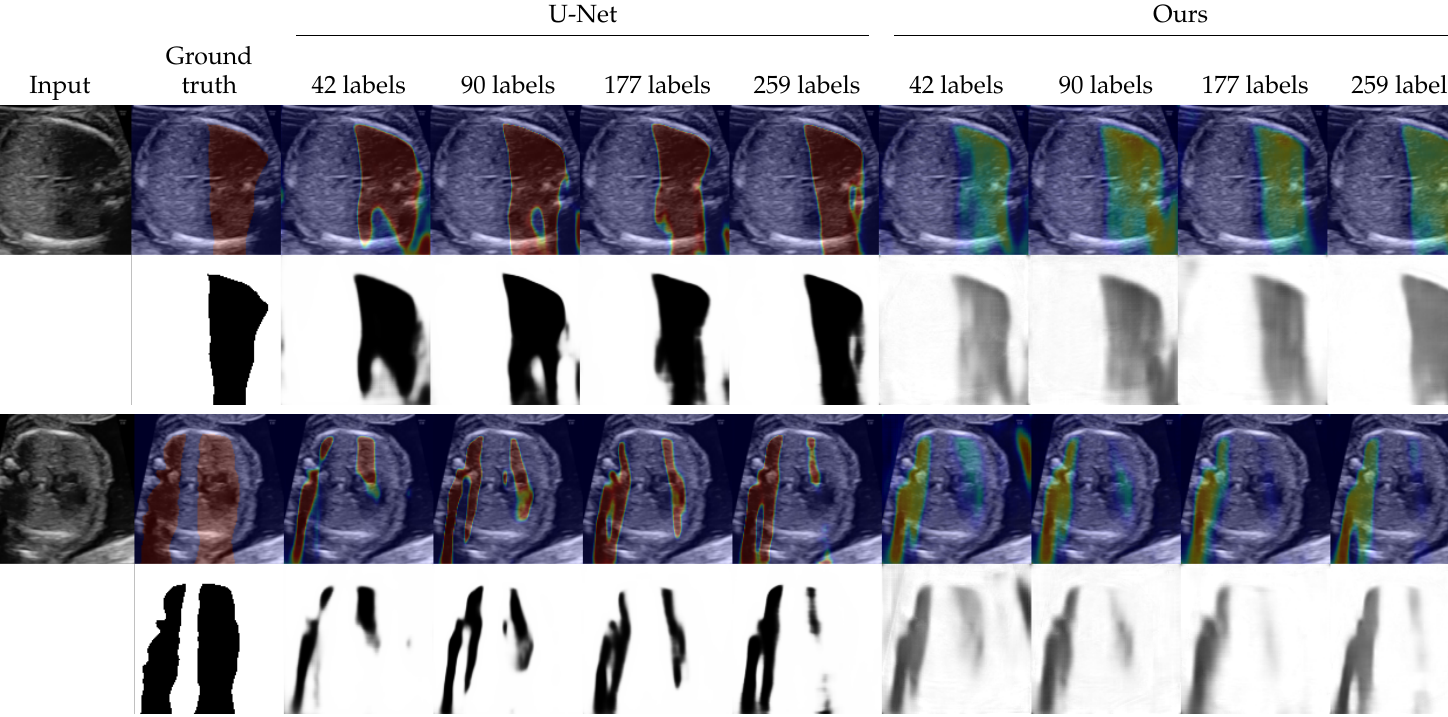
Figure 3. Examples of shadow detection results for the methods that use labels. The lower side of each example shows detection results, and the upper side shows them overlayed to the input image. For overlayed images, blue corresponds to low intensities and red corresponds to high